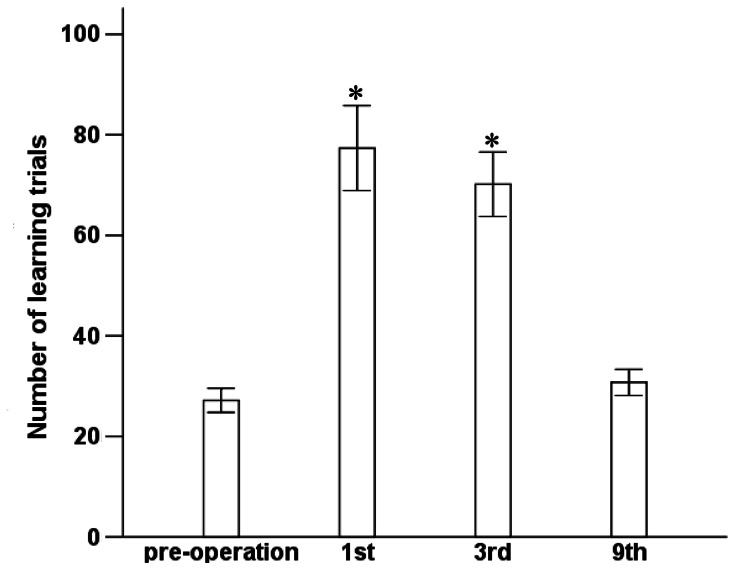
Learning and spatial memory for Y maze.Preoperatively and then 1, 3, 9 days after surgery, cohorts of rats were assessed in the Y maze apparatus to determine the trial number at which the rat first entered into the lit, unshocked arm for 9 out of 10 consecutive trial. Results are mean ± SD. *P<0.01 vs preoperative.